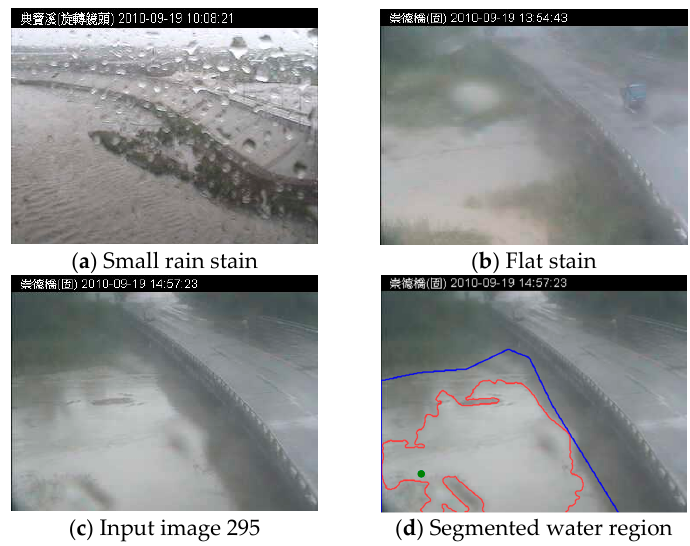
Figure 1. Two stain types: ( a ) a small stain and ( b ) a flat stain overlapping the camera lens. The effect of stains when applied to flood detection for ( c ) a stained outdoor image and ( d ) the concave region affected by stains on an image. Image 295’s flood region segmented with RegGro is represented by a red contour. The blue contour represents the ground truth, and the green dot is the location of the seed used with RegGro. (Note: The Traditional Chinese in header of ( a ) and ( c – d ) are represented the location in the Dianbao River and the Changed Bridge, respectively).